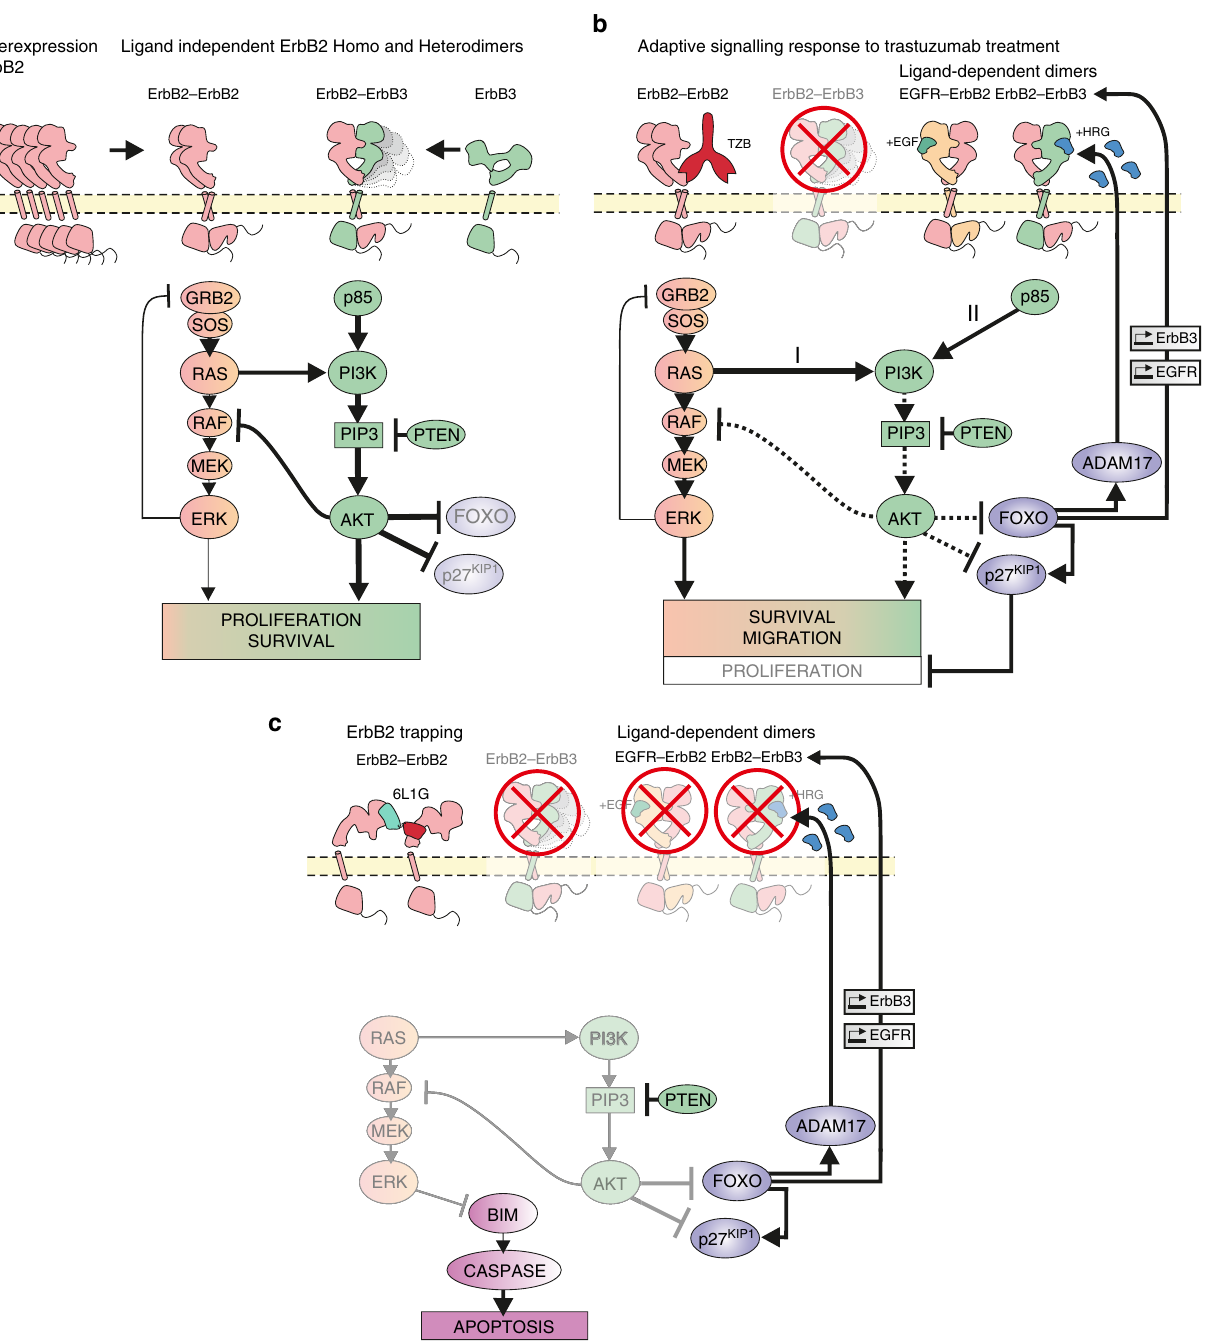
Figure 10 | Model of induction of apoptosis and adaptive resistance in response to ErbB2 blockade. ( a ) Overexpression of ErbB2 is sufficient to activate ErbB2 and ErbB3 in the absence of ligands and drives tumour growth predominantly via the ErbB2/ErbB3/PI3K/AKT signalling axis. This signalling route constitutively suppresses negative feedback regulation between AKT and ErbB3, which is however relieved upon blockade of ErbB2/3 receptors or the downstream signalling pathways. ( b ) Trastuzumab treatment induces partial ErbB2 blockade by selectively interfering with the ligand-independent ErbB2/ ErbB3 heterodimers, thereby uncoupling ErbB3 from PI3K/AKTreactivation. Here we identified a novel adaptation response that emanates from ErbB2/RAS and bypasses ErbB3 for the activation of PI3K/AKTsignalling. ( c ) Biparatopic DARPins obstruct all ligand-dependent and ligand-independent complexes of ErbB2. Such a pan-ErbB2 inhibition blocks PI3K/AKT signalling cascade and consecutive adaptive responses, leading to a stable OFF state of the ErbB oncogenic network. Consequently, intrinsic apoptosis is induced which prevents emergence of adaptive